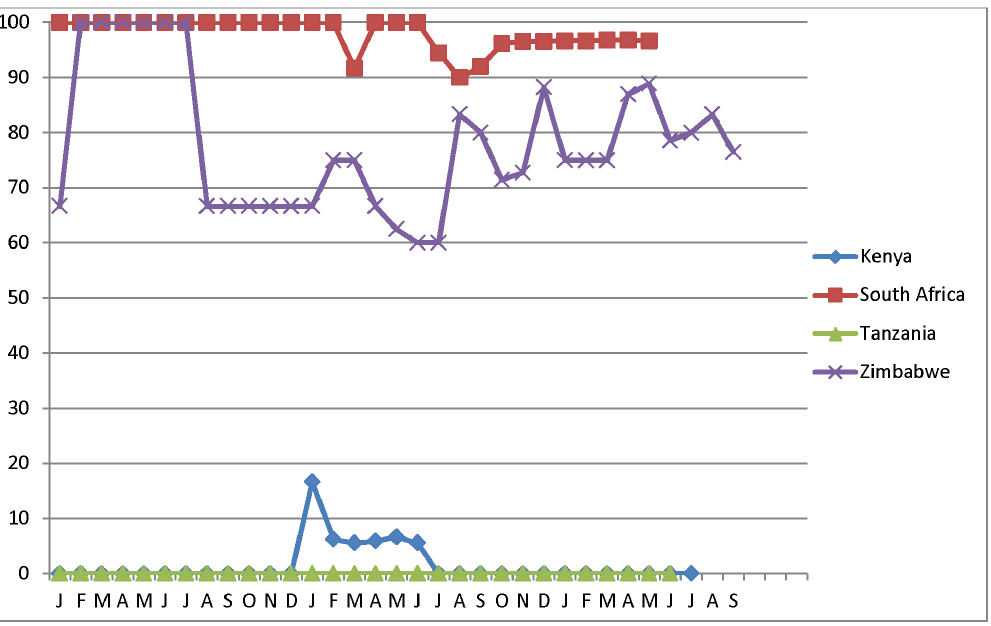
Figure 5. Proportion of sites by month and by country using electrocautery/diathermy, January 2010 – mid-2012. The number of sites on which these data are based varies markedly by month over the observation period, as shown in Figure 1.